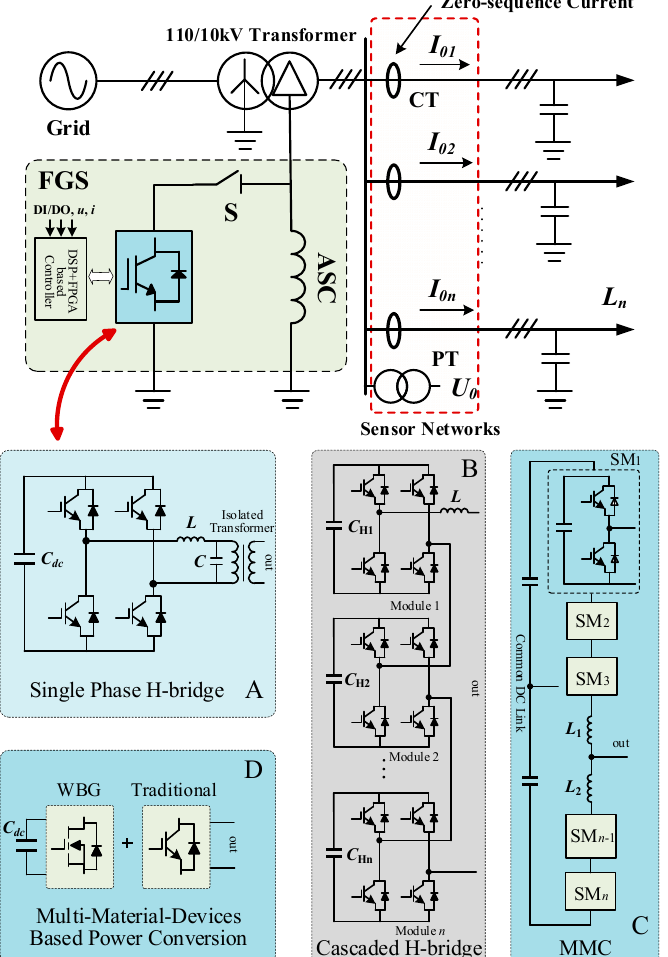
Figure 2. Schematic diagram of the flexible grounding system (FGS)-based electric distribution network with zero-sequence current/voltage sensors. And the topologies of the active inverter can be: ( A ) single-phase H-bridge; ( B ) cascaded H-bridge; ( C ) modular multilevel converter (MMC); ( D ) multi-material devices-based topology.